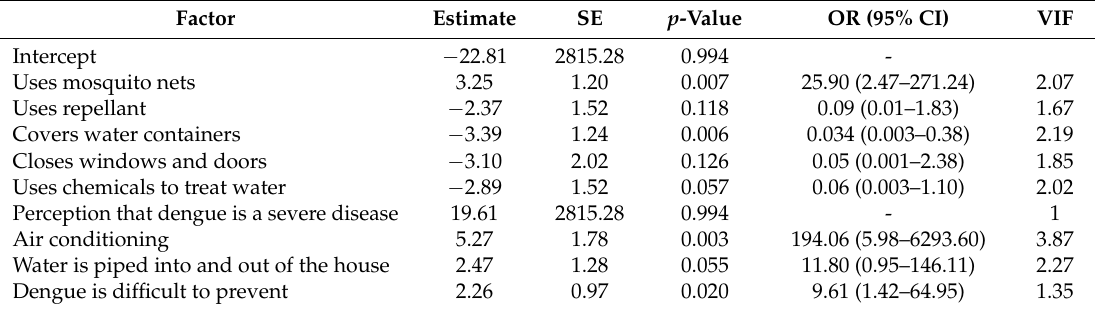
Figure 4. Suites of socio-ecological variables in the top selected models for ( A ) self-reported dengue cases, and ( B ) presence of Aedes aegypti ; positive associations in the model are denoted (+), and negative associations (-); italics denotes an important factor but direction of association is not discernable.